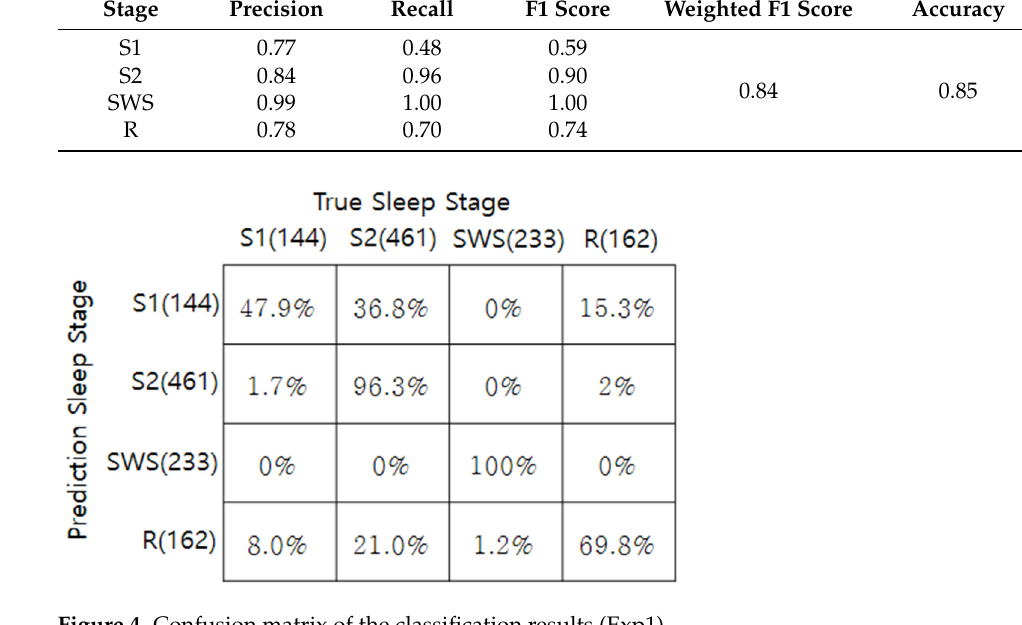
Figure 4. Confusion matrix of the classification results (Exp1).